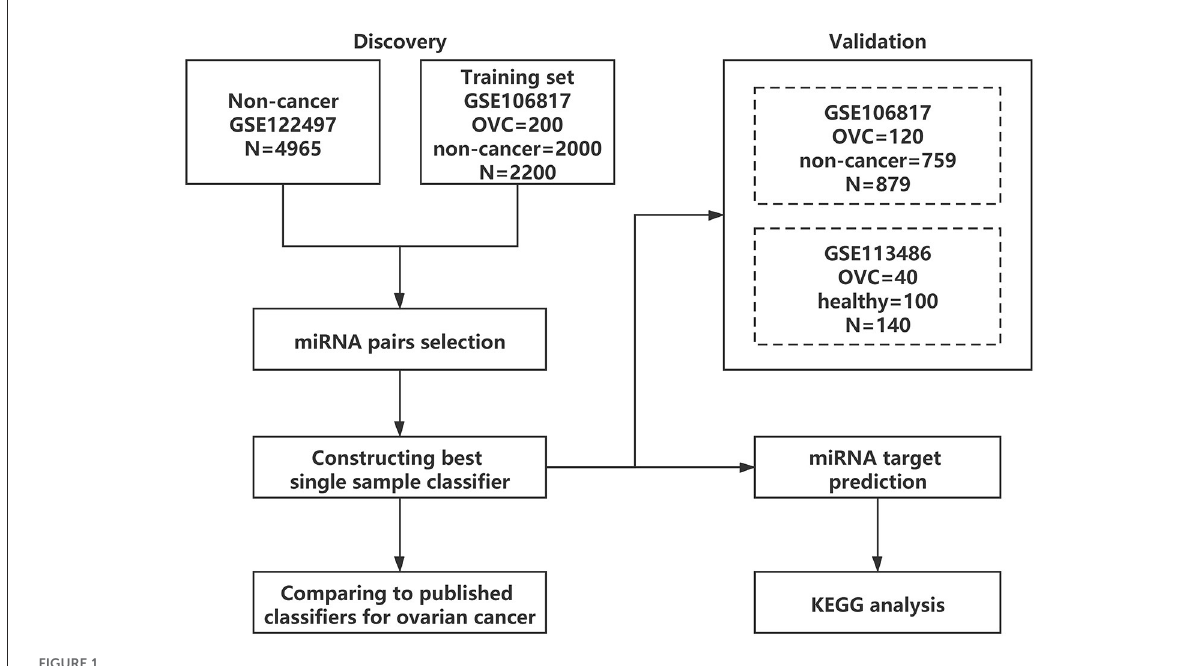
FIGURE1 Overall